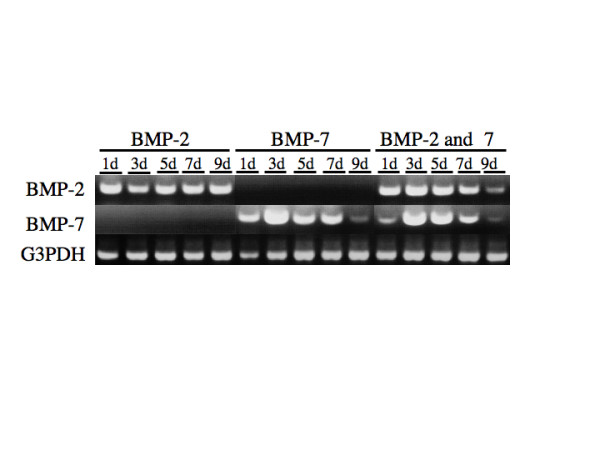
RT-PCR evaluation of BMP-2 and BMP-7 gene expression after simultaneous gene transfer into skeletal muscles. RT-PCR of human BMP-2 or BMP-7 mRNA in muscle after transfection by transcutaneous electroporation with pCAGGS and pCAGGS-BMP-2, pCAGGS and pCAGGS-BMP-7, or pCAGGS-BMP-2 and pCAGGS-BMP-7.